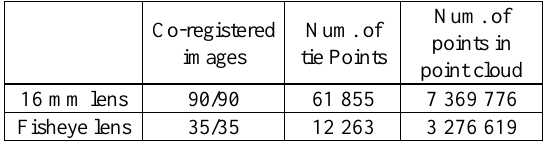
Table 1. Results of processing in Agisoft Photoscan.